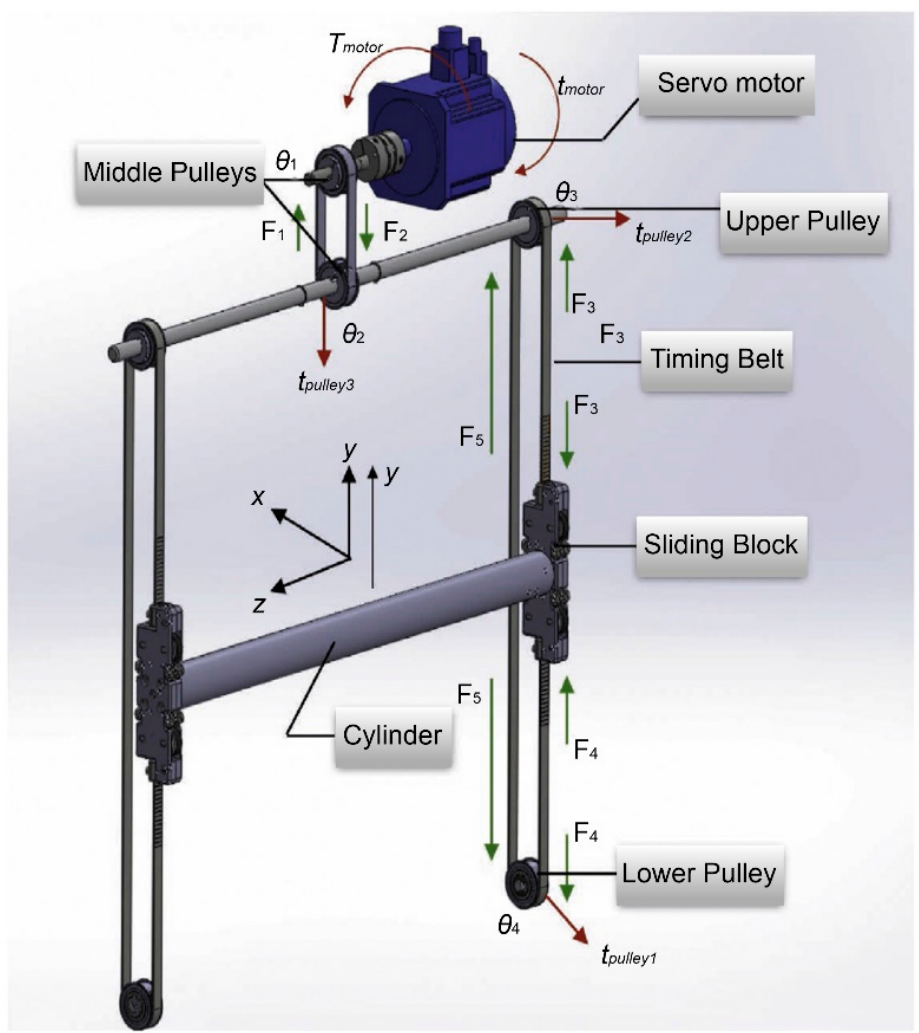
Figure 3. Symmetric V ck model with notations [11].